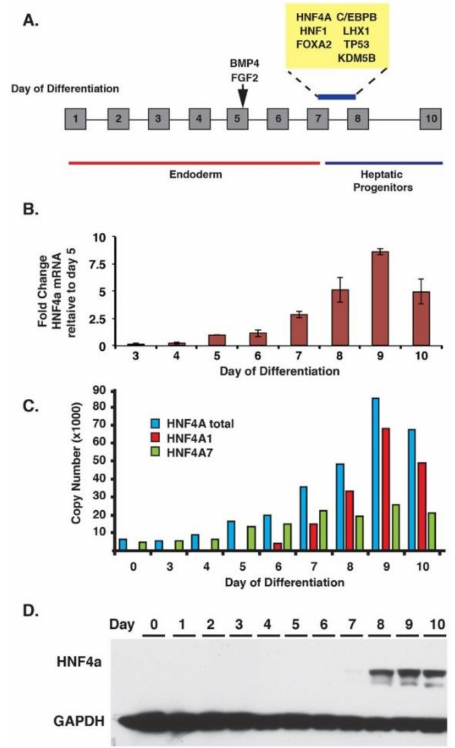
Figure 2. The onset of hepatocyte nuclear factor 4 α (HNF4A) expression coincides with the conversion of iPSC-derived endoderm to a hepatic fate. ( A ) Diagram summarizing the results of bioinformatics analyses of enriched transcription factor binding sites by Ingenuity Pathway Analyses. Several transcription factor binding sites (yellow box) were enriched in genomic sequences encoding proteins that are induced ≥ 4-fold at the endoderm (blue line) to hepatic (red line) transition, which occurs two days after addition of BMP4/FGF2 between days seven and eight of the differentiation process; ( B ) Bar graph showing relative levels of mRNA encoding HNF4A determined by real-time quantitative PCR (RT-qPCR) (standard error of the mean (s.e.m), n = 3 independent differentiations); ( C ) absolute levels of total HNF4A (blue), HNF4A1 (red) and HNF4A7 (green) mRNAs calculated by real-time RT-qPCR during the differentiation iPSCs to hepatic progenitor cells; ( D ) Immunoblot analyses of HNF4A protein levels throughout the differentiation time